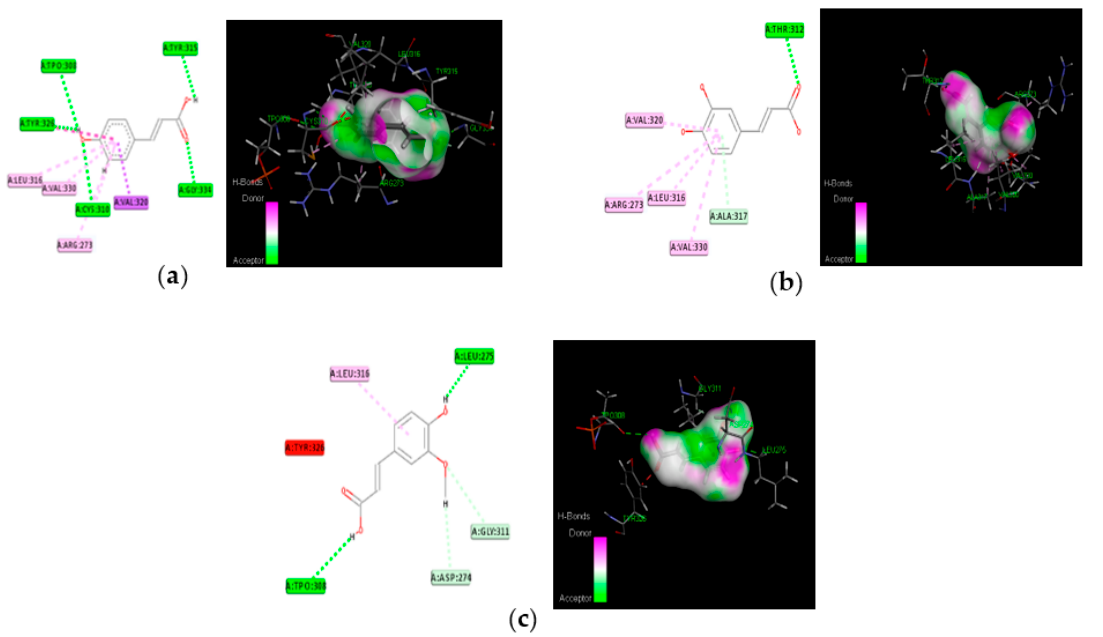
Figure 7. Molecular interaction of best three compounds with Akt; ( a ) p-coumaric acid; ( b ) caffeic acid; ( c ) trans-ferulic acid.